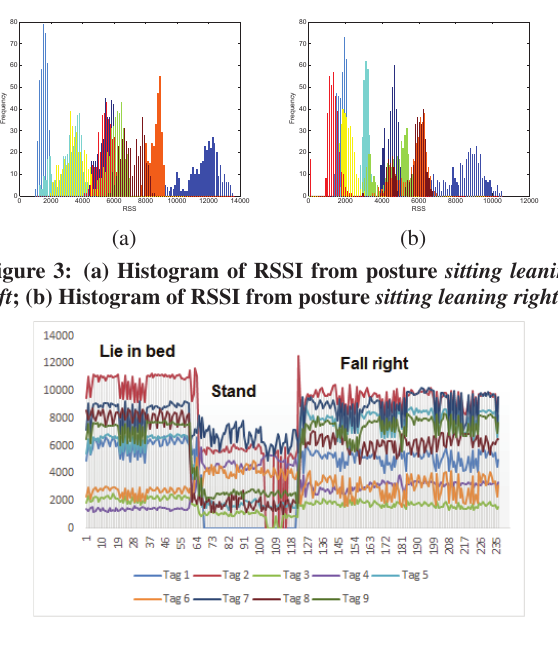
Figure 4: Different RSSI patterns of different postures